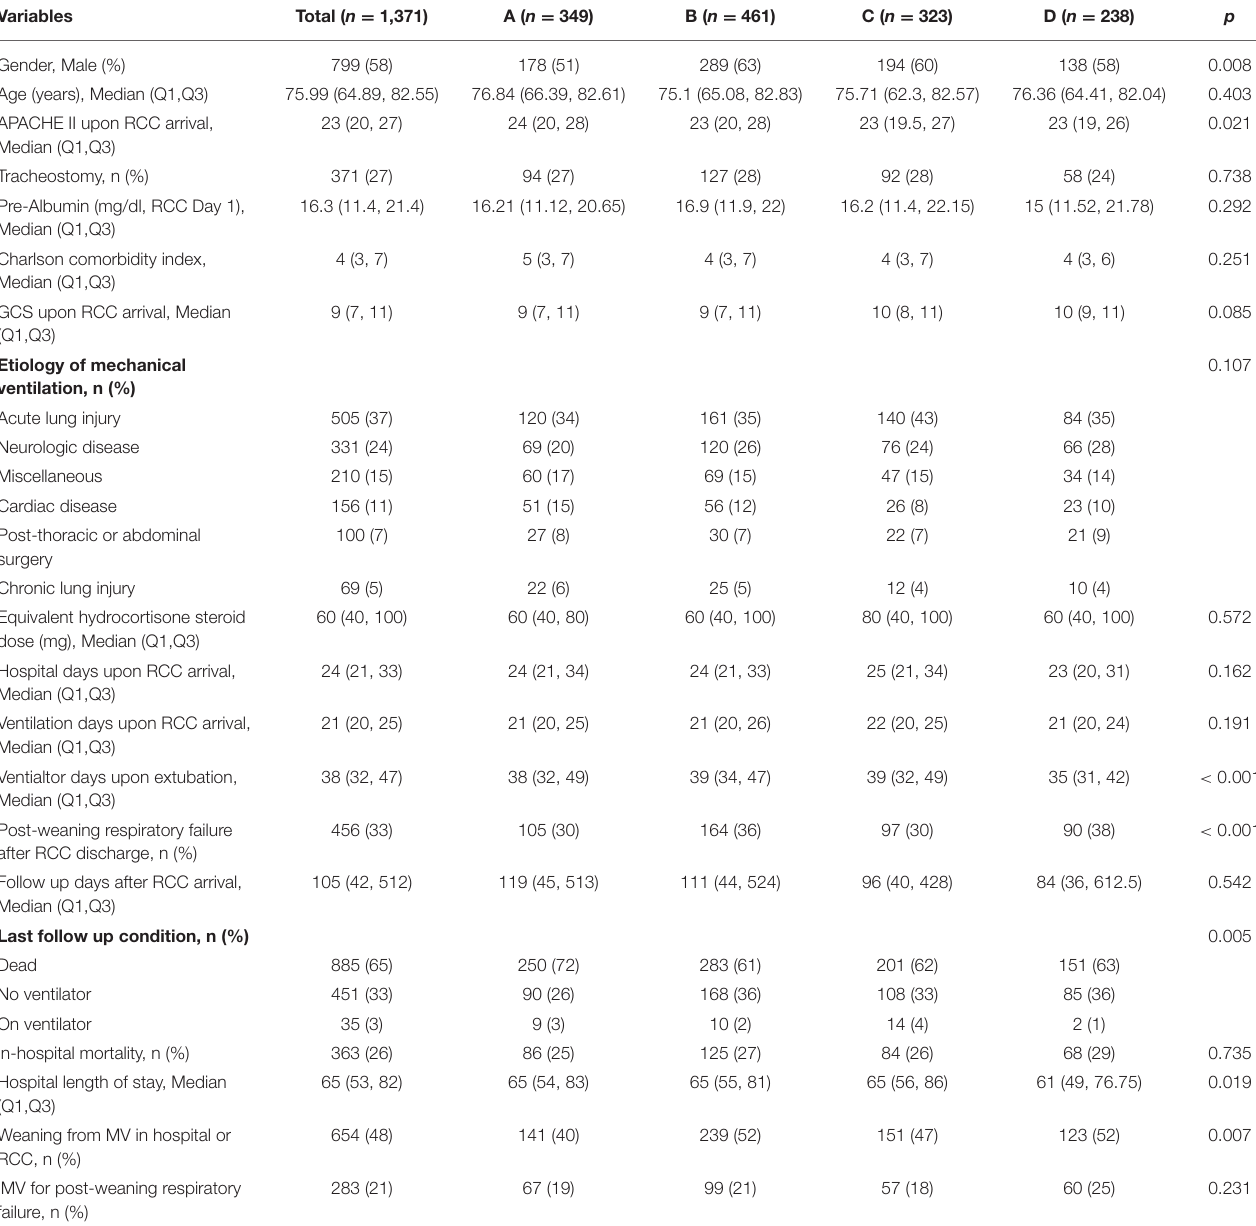
TABLE 1 | Baseline characteristics in the total population and across clusters.